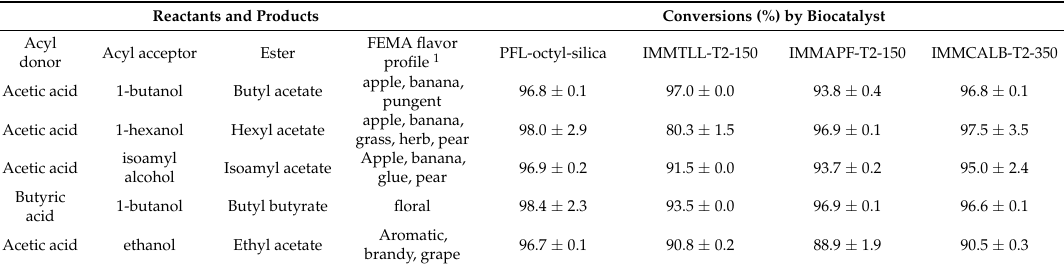
Table 1. Conversions of syntheses of short-chain carboxylic acid esters at 37 ◦ C for 24 h, catalyzed by home-made PFL-octyl-silica and commercial immobilized lipases. Reactant concentrations: 0.1 M in heptane for acids and alcohols, and 200 U/g of acid (esterification activity) 20 g/L molecular sieves for all